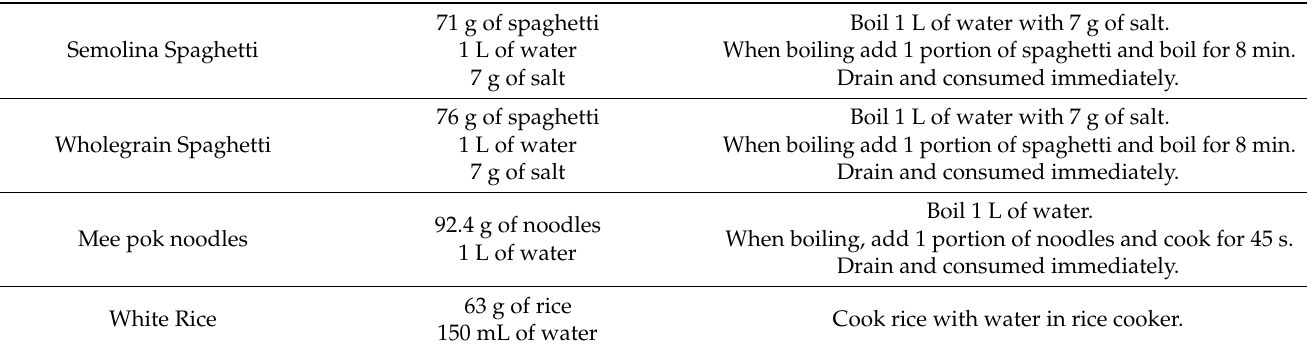
Table 2. Test meal preparation